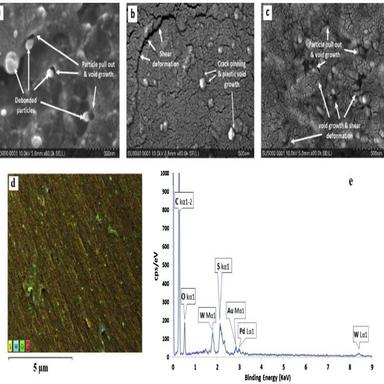
SEM images of PEEK nanocomposites containing a) 0.5 wt%, b) 1 wt% c) 2 wt% IF-WS2, d) EDX mapping and e) EDX analysis of sample containing 0.5 wt% IF-WS2.